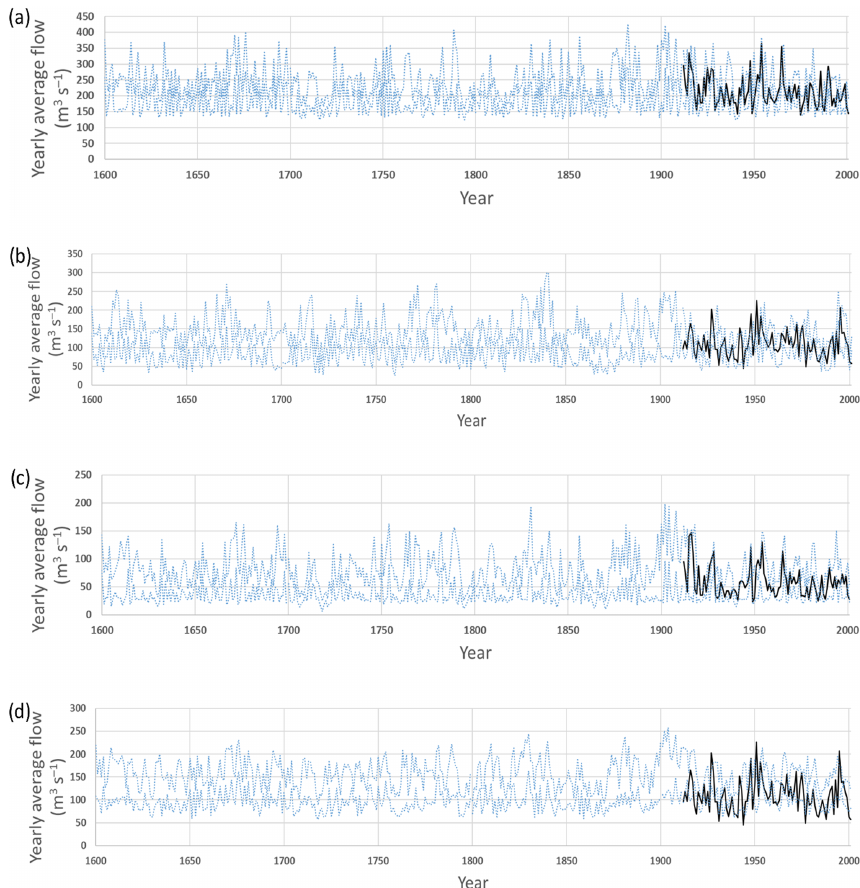
Figure 9. Time series of reconstructed yearly average flows in (a) North Saskatchewan, (b) Oldman, (c) Red Deer and (d) Bow rivers, showing the 5th and 95th percentile range of the ensemble of 500 time series flows as a representation of uncertainty for 1600–2001 (dotted blue lines) as well as the observed reference flow (solid black